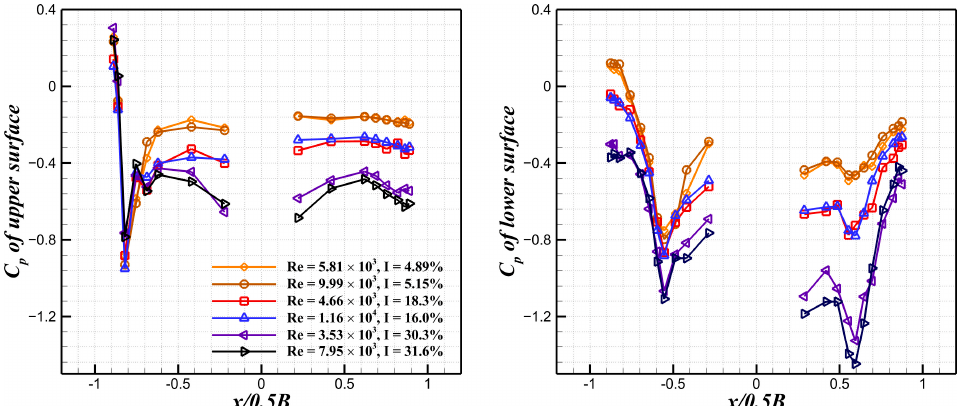
Figure 11. The time-averaged surface pressure distributions of the twin-box girder with body-height grid interference at different Reynolds numbers when turbulence intensities are close.